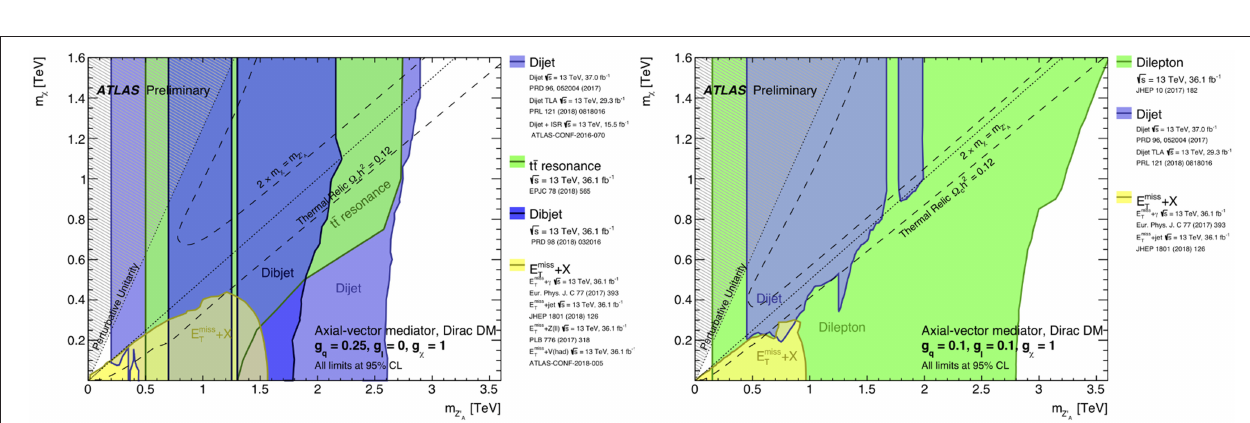
FIGURE 3 | Regions in a DM mass-mediator mass plane excluded at 95% CL by the ATLAS dijet, dilepton and mono-X searches, for axial-vector mediator simplified models with two choices of the couplings: leptophobic scenario (Left) and leptophilic scenario (Right). Exclusions are computed for the DM coupling g χ , the quark coupling q g , universal to all flavors, and the lepton coupling q l , indicated in each plot. The dashed curve “thermal relic" indicate combinations of DM and mediator mass that are consistent with a DM density of (cid:127) 0.12 h 2 and a standard thermal history. A dotted curve indicates the kinematic threshold where the mediator can = decay on-shell into DM. Excluded regions that are in tension with the perturbative unitary considerations are indicated by shading in the upper left corner.